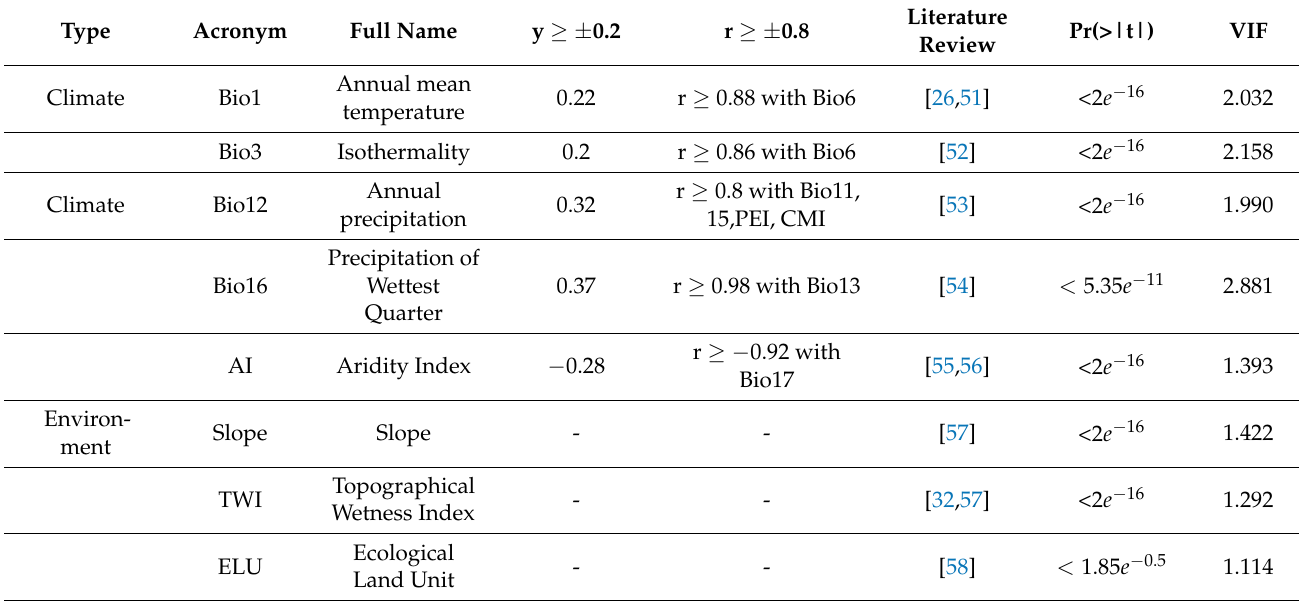
Table 2. Climate and environmental variables.